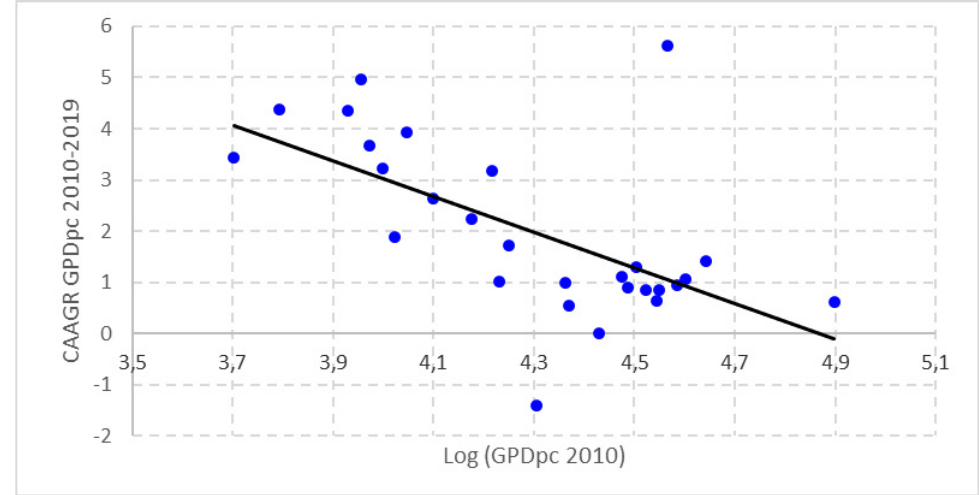
Figure 2. GDPpc’s Beta convergence of EU-28 countries (2010–2019). Source: Prepared by authors based on Eurostat.